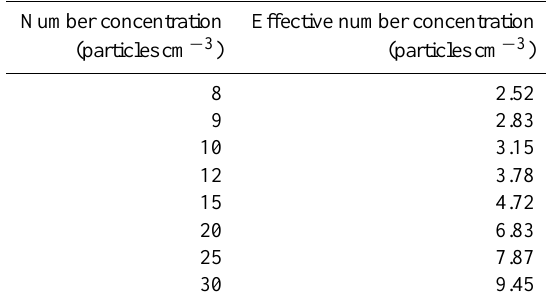
Table 1. Total number concentrations and effective number concen- trations used in the present work.